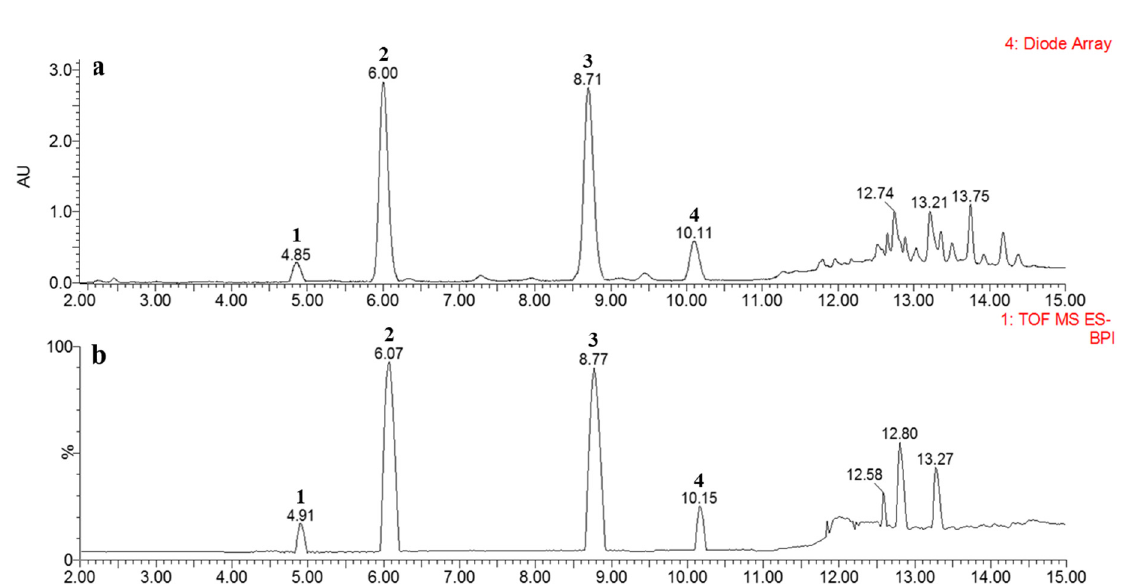
Table 2. Spectral characteristics and contents (mg/g) of the four investigated compounds in rhizomes of Dryopteris crassirhizoma . Peak Molecular Formula (no.)